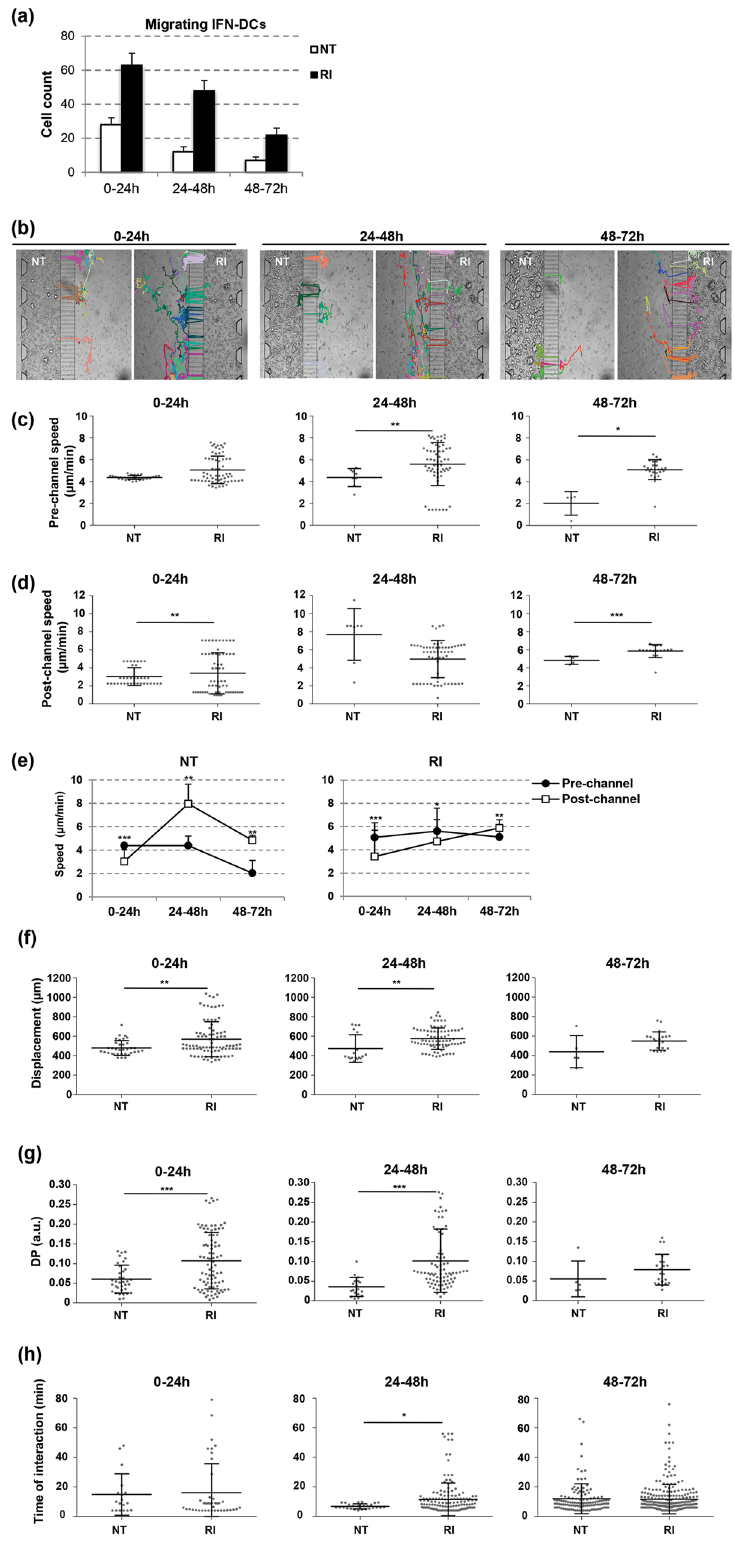
Figure 5. Analysis of IFN-DCs and RI-treated SW620 cells interaction. ( a ) Quantification of migrating IFN-DCs crossing connecting-channels towards NT or RI-treated SW620 cells by the revised unsupervised algorithm for cell tracking analysis of 0–72 h time-lapse recording. Images were acquired every 2 min by a Juli Smart microscope (4 × magnification). Means ± s.d. are shown. Three independent experiments were analysed. ( b ) Migratory patterns of IFN-DCs toward NT or RI-treated SW620 cells were analysed in 0–72 h time-lapse experiments with cell tracking analysis. Paths of each IFN-DC crossing the connecting-channels from